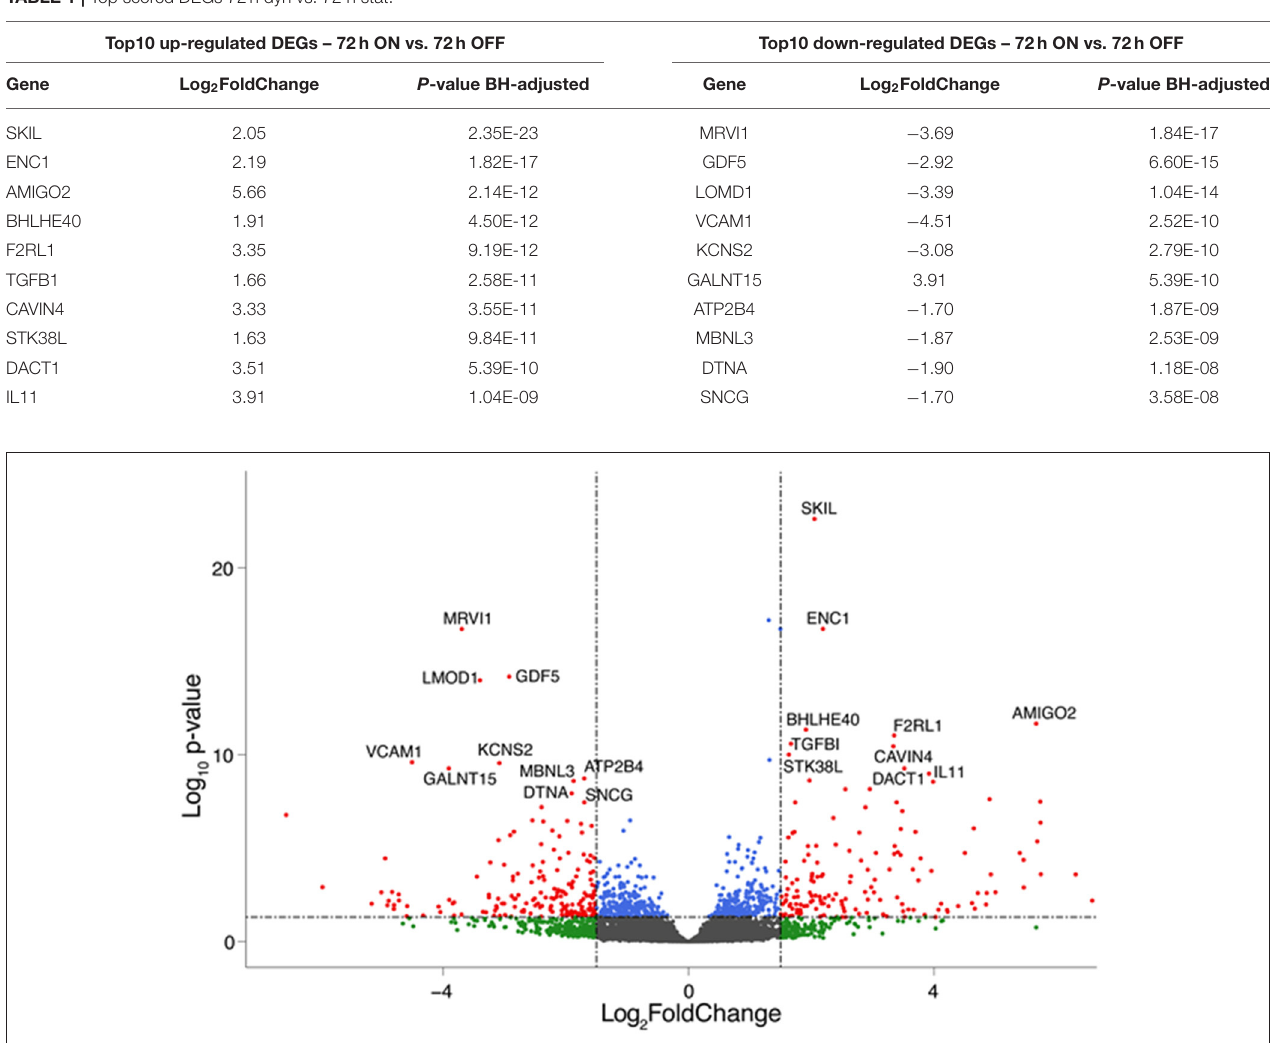
FIGURE 2 | Top regulated genes after 72h of mechanical strain. Volcano plot showing significant genes in the 72 h dyn vs. 72h stat comparison. The top 10 upregulated and down regulated DEGs are highlighted. Genes are colored if they pass the thresholds for BH-adjusted p -value and/or LogFC (blue if BH-adjusted p -value ≤ 0.05, green if logFC < − 1.5 or logFC > 1.5, red if they pass both